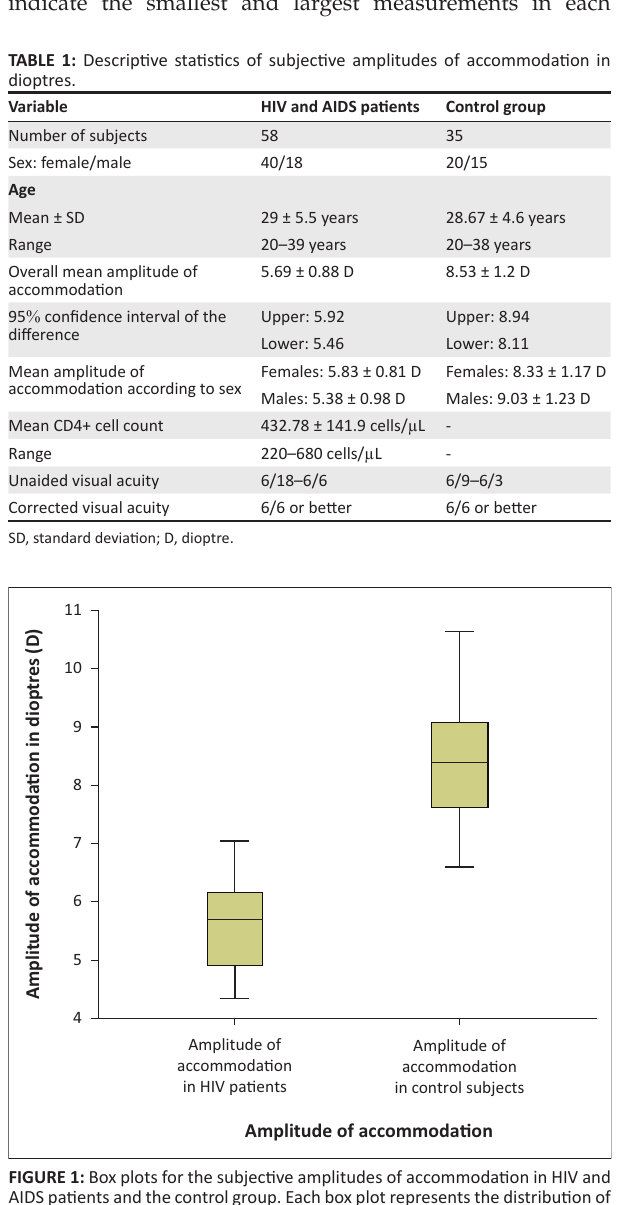
FIGURE 2: Correlation between the amplitude of accommodation in HIV patients and their